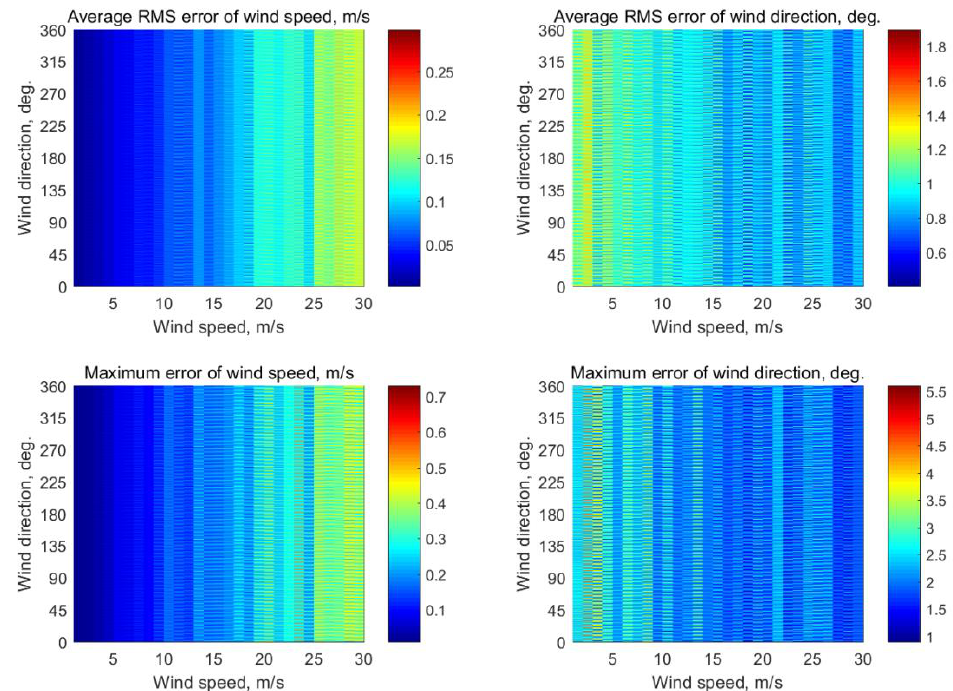
Figure A6. Simulation results of the use of only one incidence angle of 55° for wind retrieval.